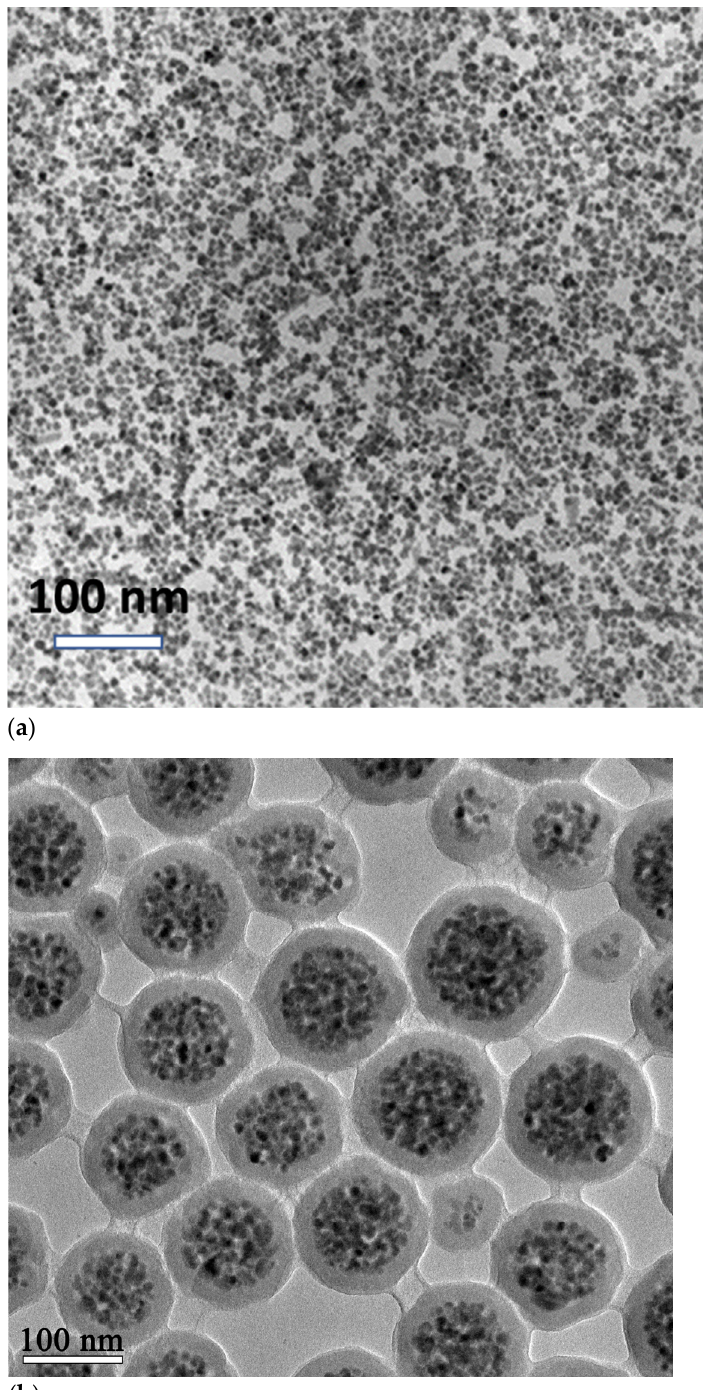
Figure 1. ( a ) Transmission electron microscopy (TEM) image of the commercial samples (image sup- plied by Ferrotec, Bedford, NH, USA). ( b ) Transmission electron microscopy image of Si/ PS/Fe 3 O 4 . The nanoparticles of Fe 3 O 4 (darker spots) are embedded in the spherical polystyrene matrices (lighter spheres).